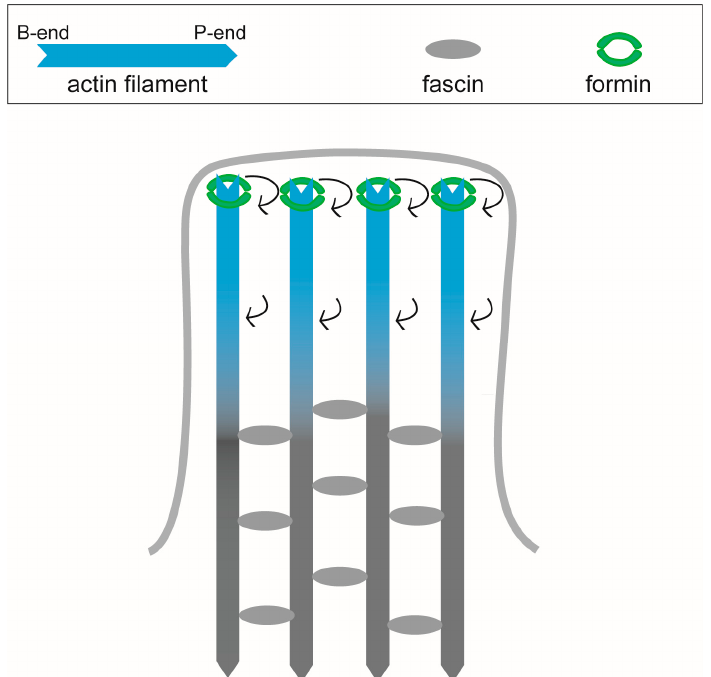
Figure 4. Extension and stabilization of filopodia. Similar to lamellipodia, in filopodia, formin binds to the barbed end of actin filaments and untwists the filaments. Since fascin can bind to actin filaments regardless of this structural change, filaments are bundled in filopodia. The formin-induced untwisting is presumably blocked and not propagated to the pointed-end of filaments by the immobilization by fascin. Cofilin cannot bind not only to the untwisted segments near the tip of filopodia, but also to the bundled sections, since those bundled sections cannot be supertwisted.